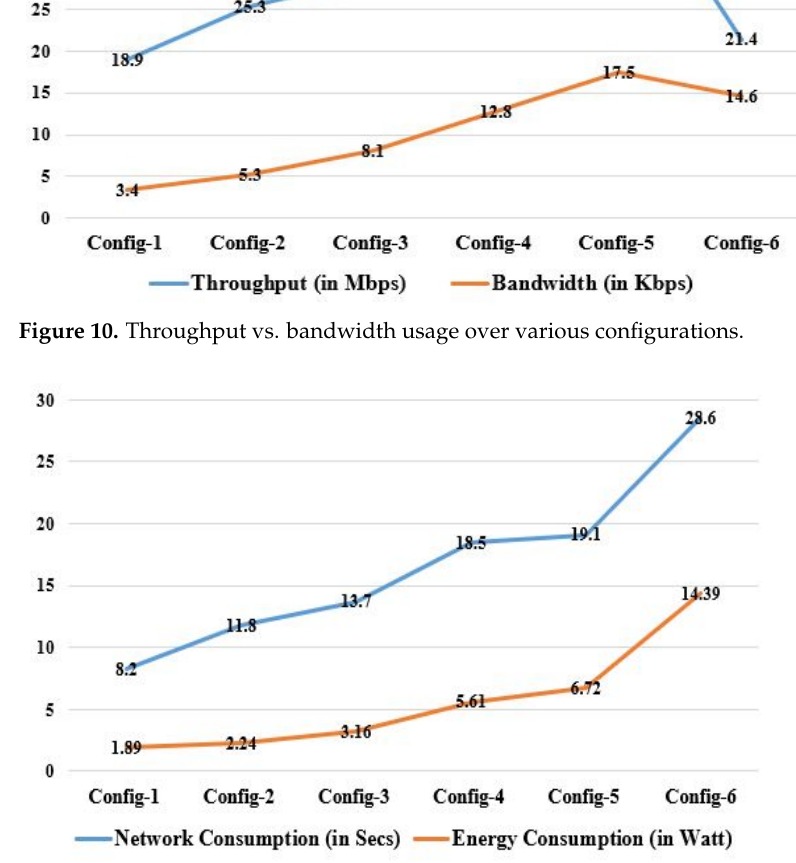
Figure 11. Network vs. energy consumption over various configurations.